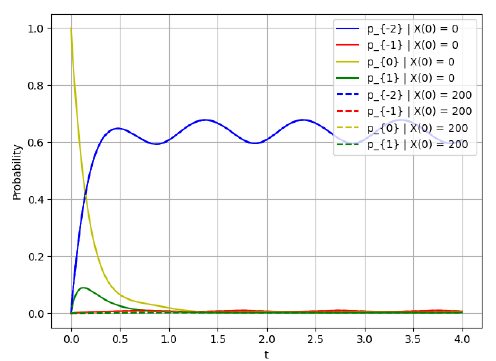
Figure 4. Probability p − 2 ( t ) , p − 1 ( t ) , p 0 ( t ) , p 1 ( t ) for t ∈ [ 0,4 ] ; this figure shows the rate of conver- gence.